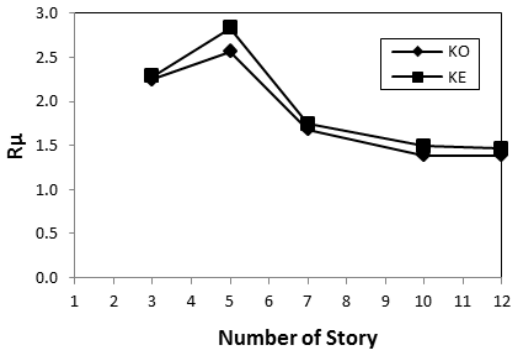
Fig. 11. Number of story- ductility factor.